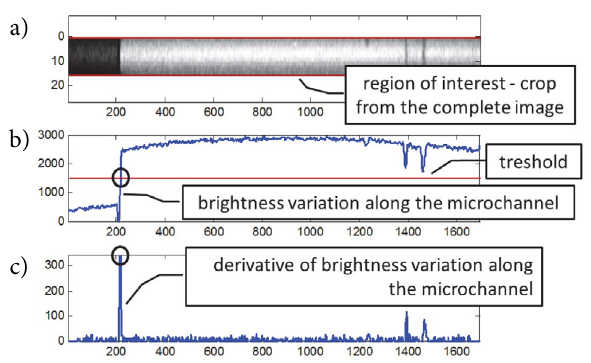
Figure 5. Identification of the meniscus location – a) ROI of chan- nel #1 cropped from the complete image (Figure 5); b) brightness variation; c) derivative of the brightness